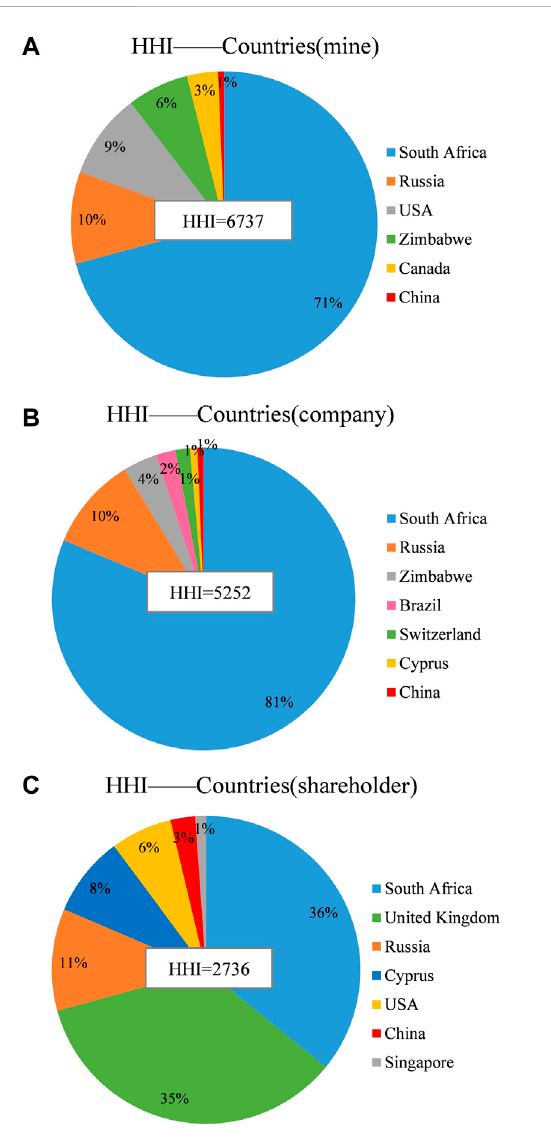
FIGURE 5 Global platinum market concentration: (A) HHI index of platinum producing countries, (B) HHI index of platinum producing companies, (C) HHI index of platinum mines.